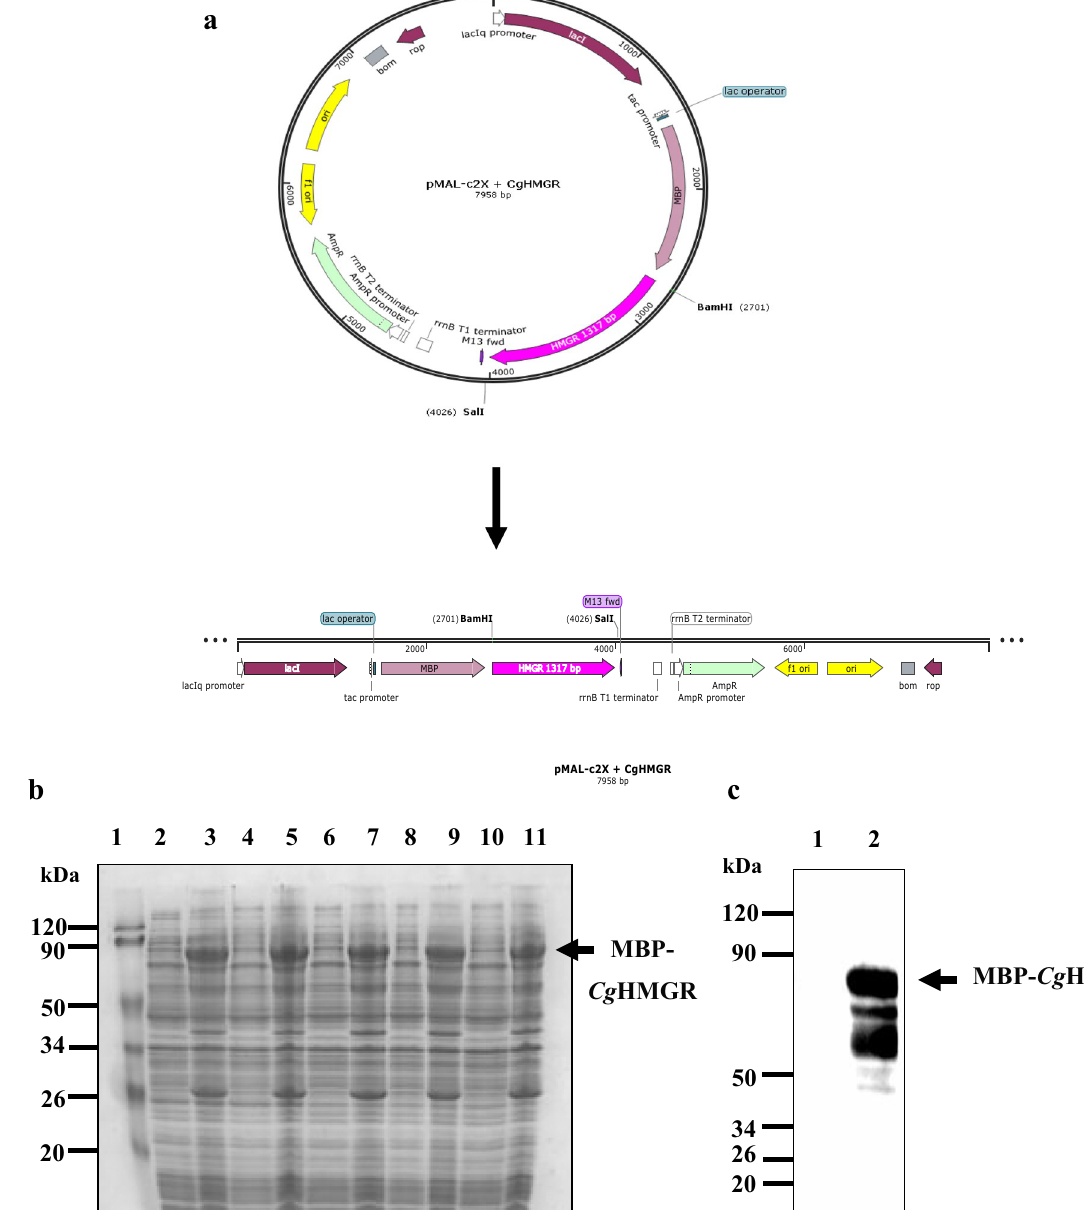
Figure 4. Graphic representation, overexpression, and detection of the recombinant Cg HMGRE680Q, Cg HMGRE711Q, Cg HMGR805A, Cg HMGRM807R and Cg HMGRE680Q-M807R proteins. ( a ) Cartoon illustration of the p-MBP- Cg HMGR (where MBP refers to the maltose-binding protein), which was used to obtain and express mutant Cg HMGR proteins. ( b ) SDS-PAGE of the expression of the mutated proteins: Lane 1, molecular weight marker; lanes 2, 4, 6, 8 and 10, extract of cells before induction; lanes 3, 5, 7, 9 and 11, extract of cells after induction with IPTG. The full-length gel is included in Supplementary Information (Fig. S4a). ( c ) Example of the verification of protein identity by Western blot based on anti-MBP antibodies: Lane 1, molecular weight marker; lane 2, uninduced cell extract; lane 3, induced cell extract. The full-length blot is also shown in Supplementary Information (Fig.